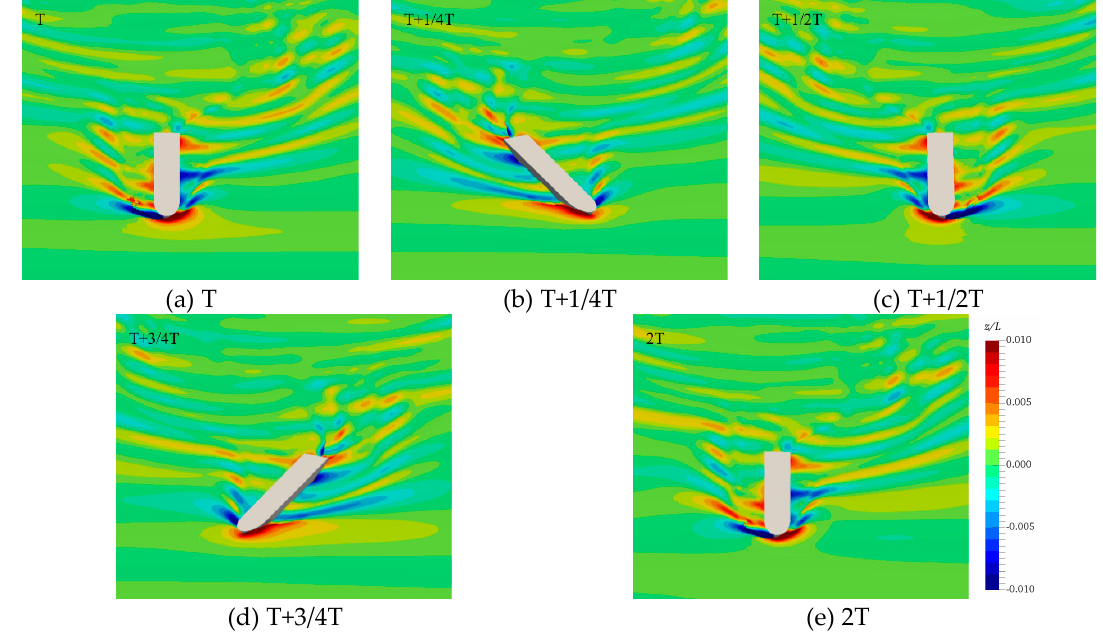
Figure 17. Evolution of the free surface in one period in CASE PY8.